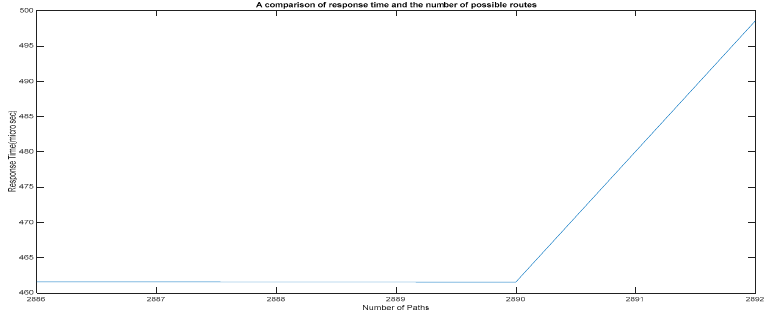
Figure 12. A comparison of response time and the number of possible routes.